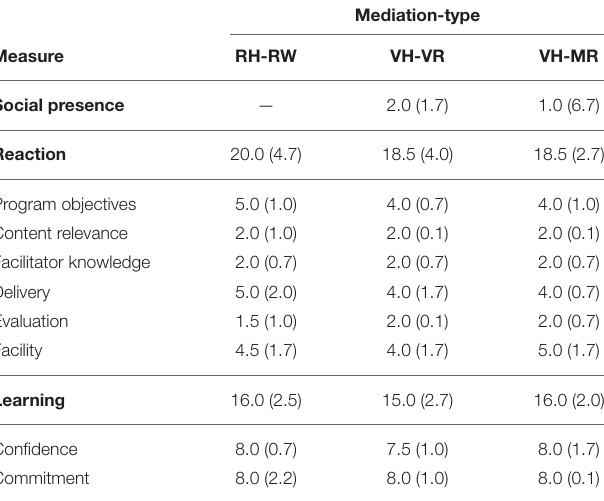
TABLE 2 | Descriptive statistics [median value (IQR)] results for Social Presence (first row); Reaction (second block of rows) and items (third block of rows); Learning (fourth block of rows) and items (Fifth block of